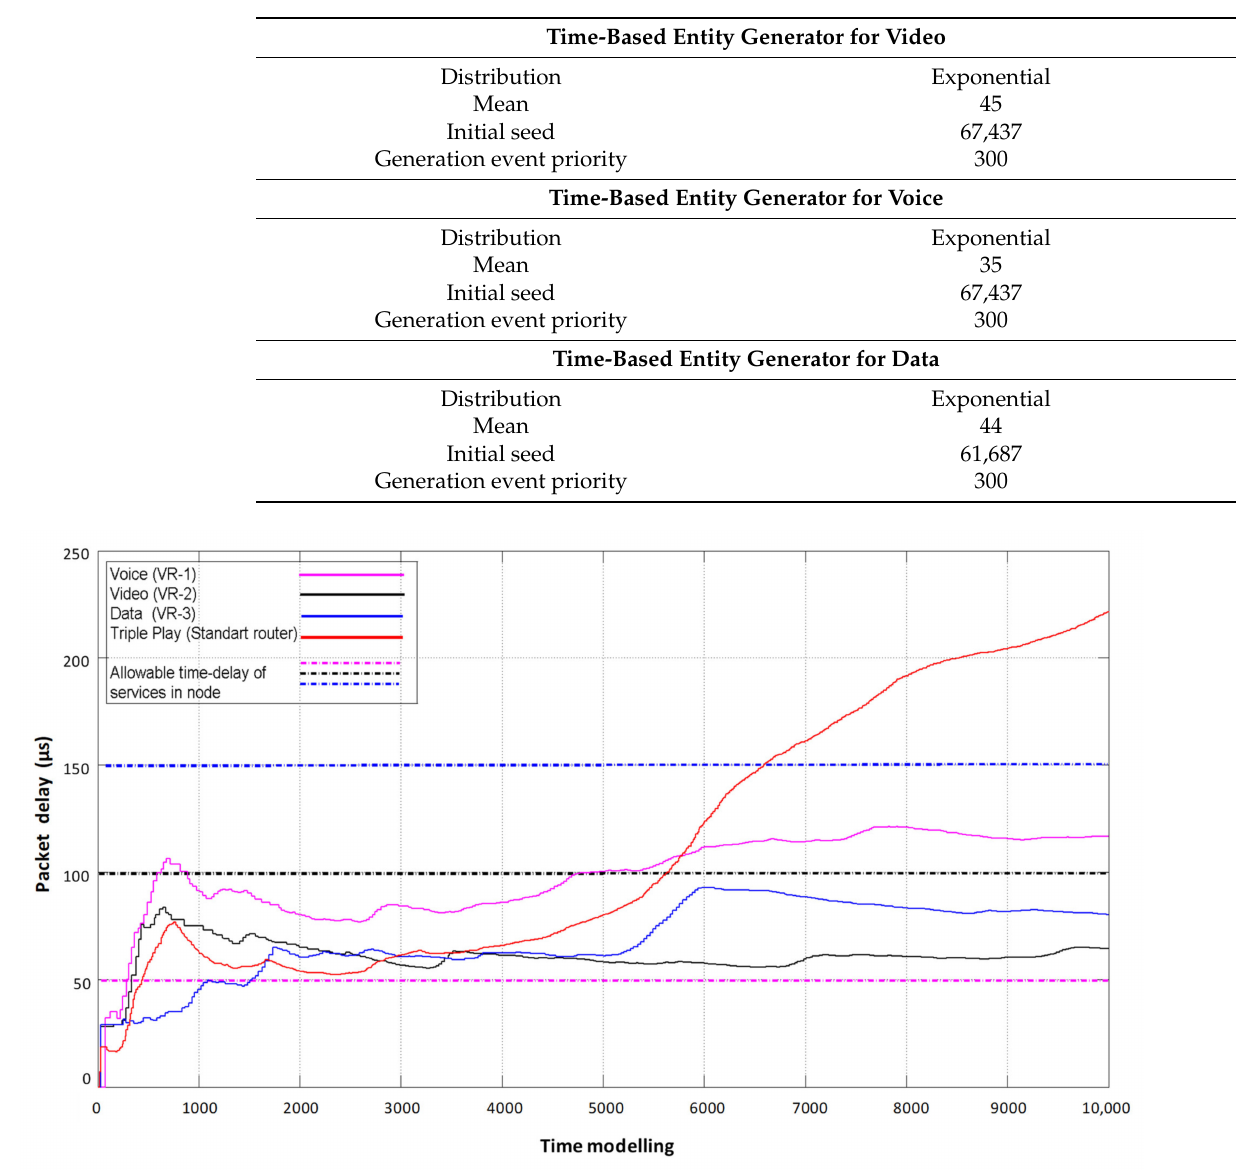
Table 3. Time-based entity generator parameters.